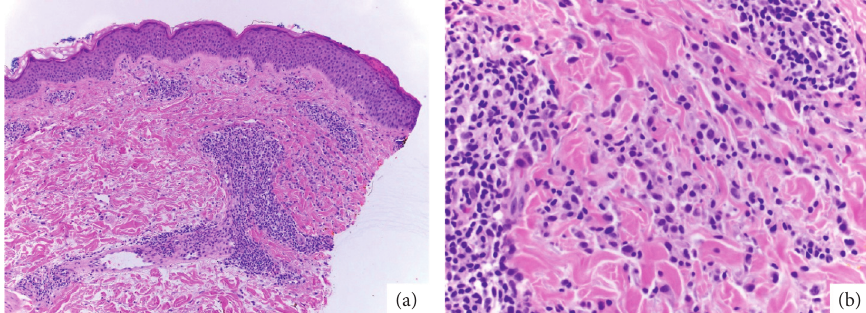
Figure 2: Histopathology with H&E demonstrating (a) epidermal acanthosis and mild spongiosis at 100X. There is dense perivascular inflammation, and interstitial histiocytes are noted at the edge of the specimen. (b) Histiocytes are seen between collagen bundles as well as scattered eosinophils,